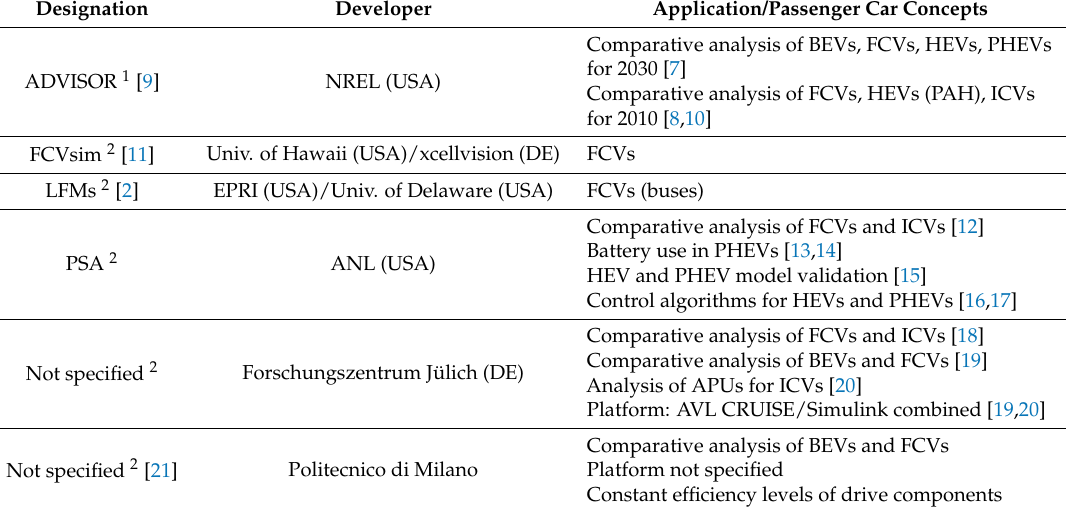
Table 1. Simulation-based fuel consumption analysis—literature overview. Simulation platform: Matlab/Simulink ® (release R2013a, The Mathworks, Inc., Natick, MA, USA) (unless otherwise